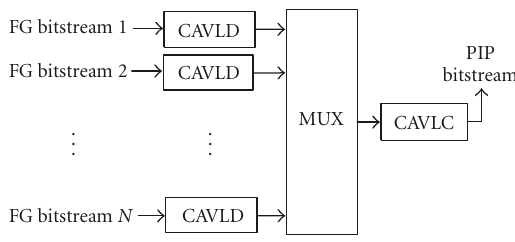
Figure 7: A transcoding scheme for channel preview.